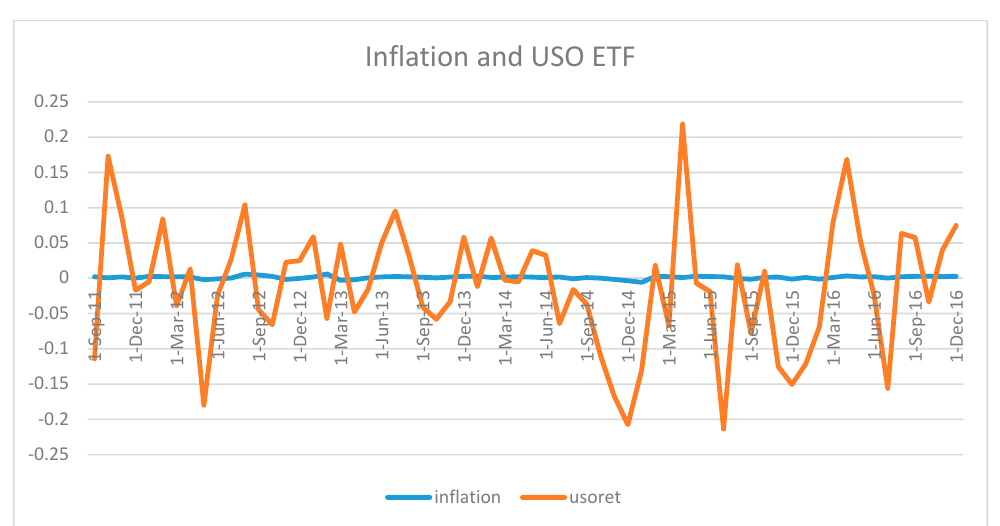
Figure 3. Inflation and oil index graph. Int. J. Financial Stud. 2017 , 5 , 28